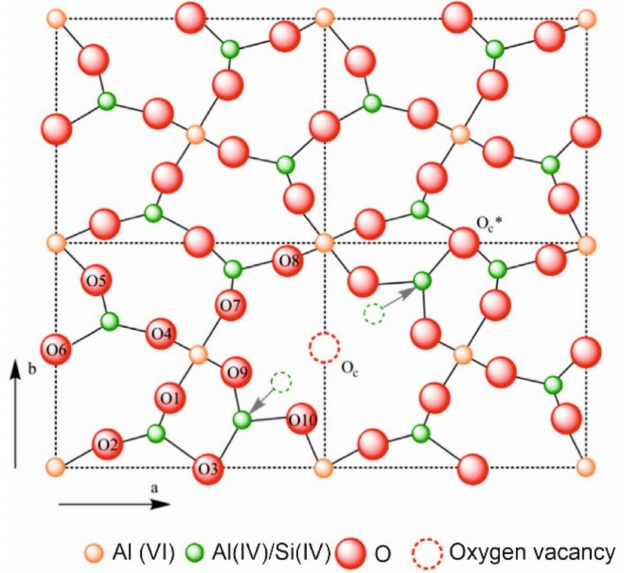
Figure 4. Crystal structure of mullite along c-axis